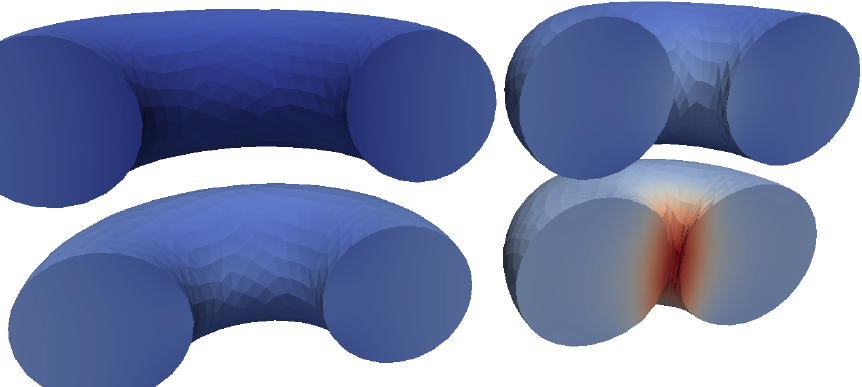
Figure 5. Cross-sections of the initial torus mesh used for the calculations ( top left ) evolving to that of the almost collapsed drop ( bottom right ) with no wire current to the same scale. Indicative colouring corresponds to MVP values. Note the broadly continued circular minor cross-section throughout the collapse owing to the absence of any magnetic field.